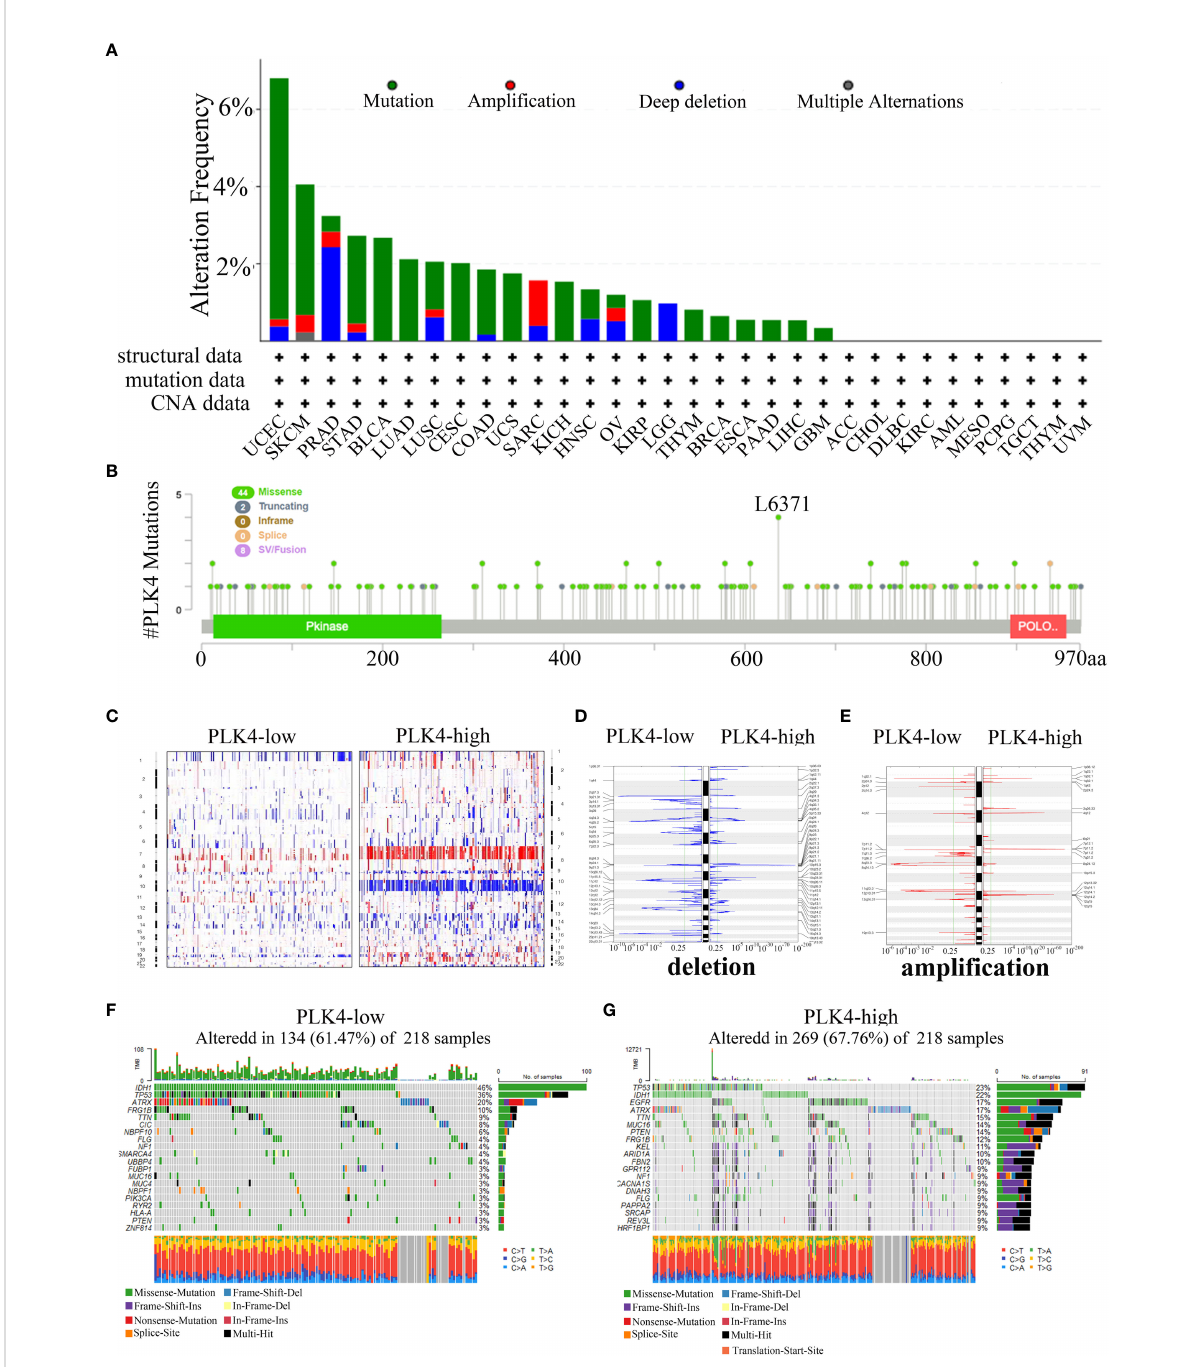
FIGURE 7 Analyzing complex cancer genomics and clinical pro fi les in relation to PLK4 expression and distinguishing certain genomic pro fi les associated with the expression of PLK4. (A) Mutation rate of PLK4 gene in various tumors. (B) By using the cBioPortal tool, the mutation sites of PLK4 have been identi fi ed in multiple tumor types. (C) CNA pro fi les regarding high and low levels of expression of PLK4 . (D, E) An analysis of the frequency of ampli fi cations and deletions in gliomas with high and low expression levels of the PLK4 gene (Blue, deletion; red, ampli fi cation). (F, G) A comparative analysis of glioma somatic mutations (25% PLK4 low and 25% PLK4